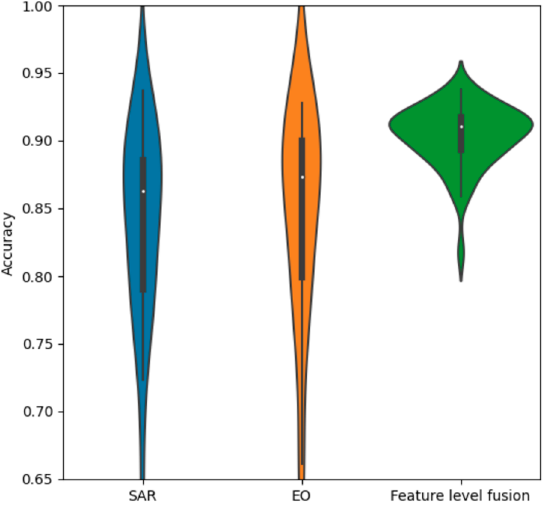
Figure 22. Accuracy distributions of ResNet18 feature fusion vs. SAR and EO.